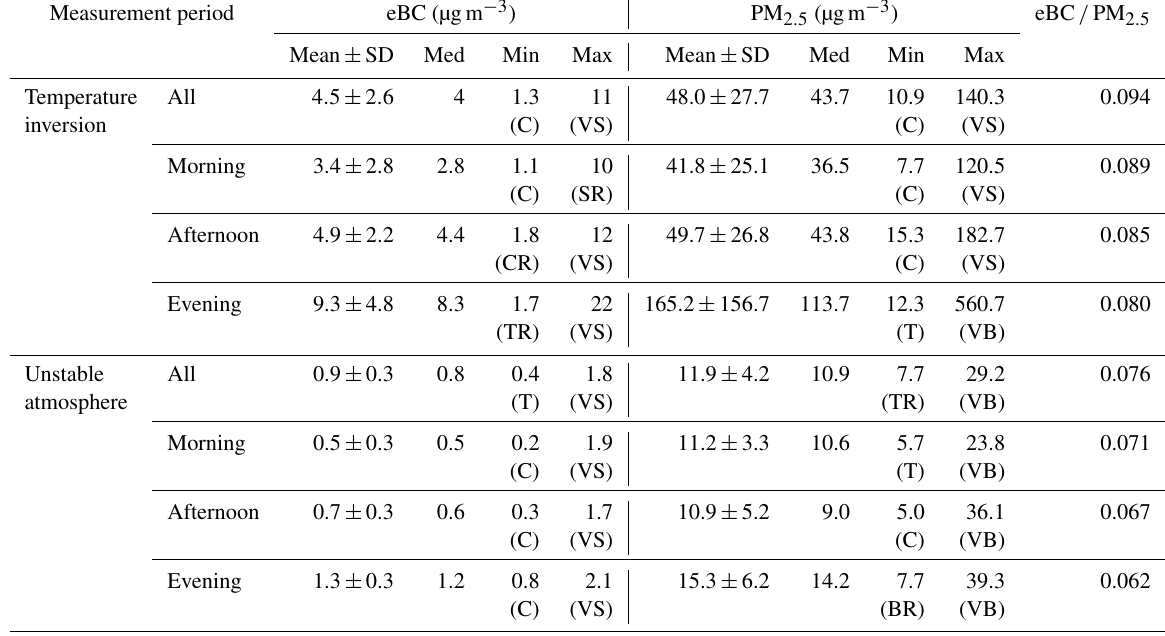
Table 4. Summary of eBC and PM 2 . 5 mass concentrations measured along the route of the Retje karst depression. Mean with standard deviation (AM ± SD), median (MED), and average eBC / PM 2 . 5 ratio of the whole route during temperature inversions and during unstable atmosphere shown for all the runs (all) and separately according to different run times. MIN and MAX represent the value and location of the pollutant minimum and maximum along the route.